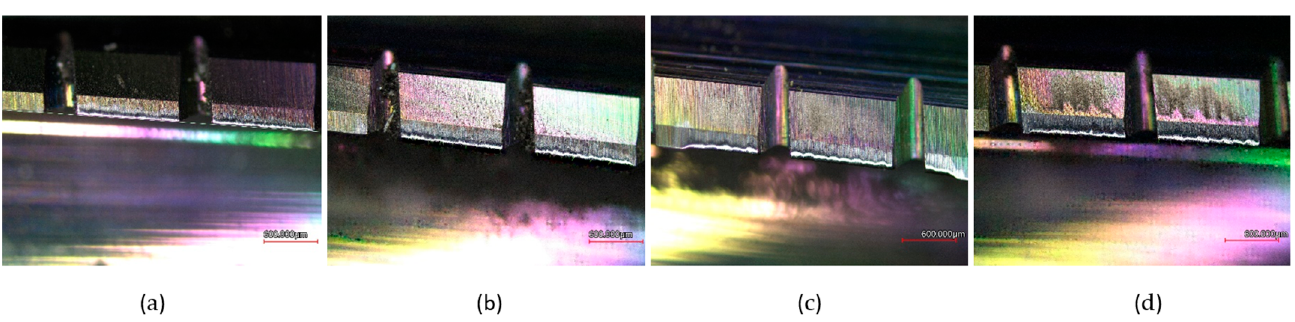
Figure 30. Tool wear of the ECSSF milling tool, laminate thickness 1 mm. ( a ) Tool tooth path 5 × 165 m; ( b ) tool tooth path 10 × 165 m; ( c ) tool tooth path 15 × 165 m; ( d ) tool tooth path 20 × 165 m.